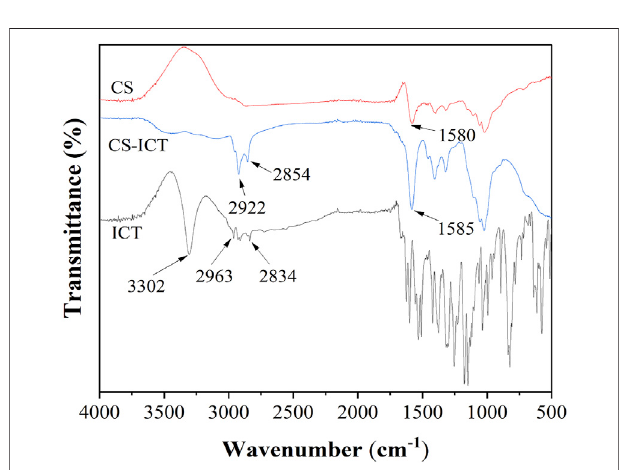
FIGURE 4 | Infrared spectrum images of ICT, CMC, and ICT-CMC